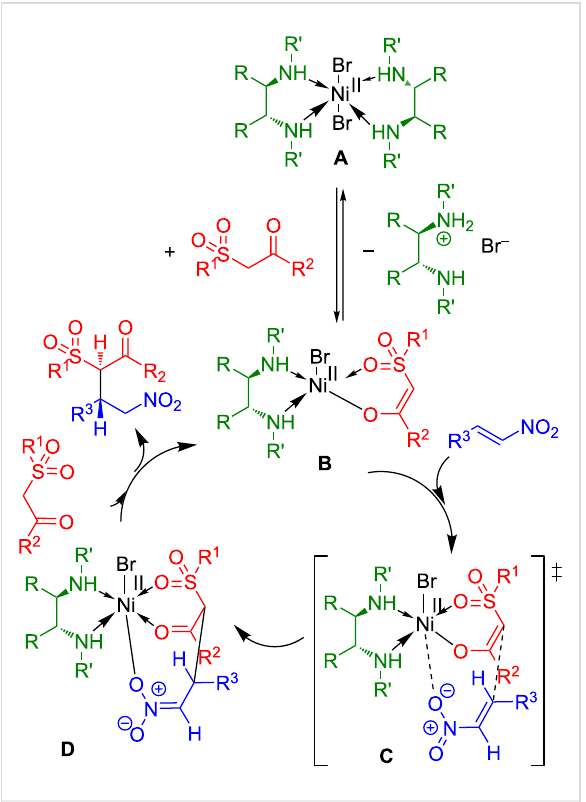
Scheme 1: The proposed mechanism of asymmetric addition of β -ketosulfones to